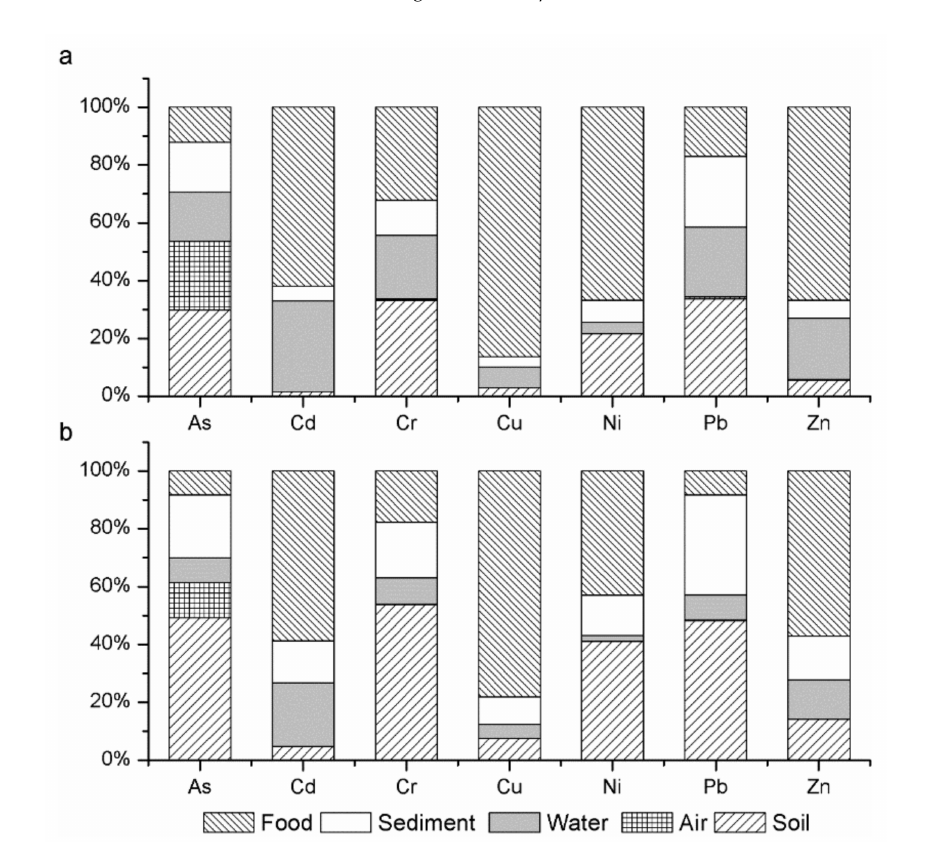
Figure 2. The contribution of Multi-media to the average daily exposure dose. ( a ) Each media’s contribution to the average daily dose of the local adults; ( b ) Each media’s contribution to the average daily dose of the local